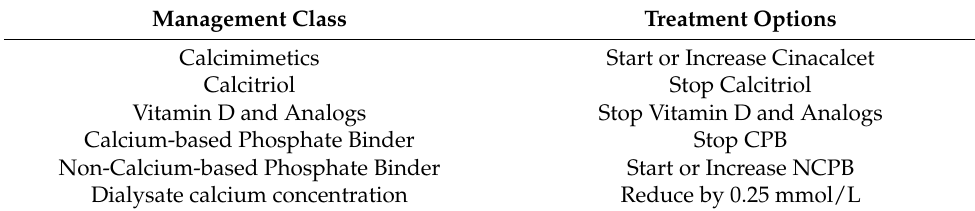
Table 5. A sample generic recommendation.